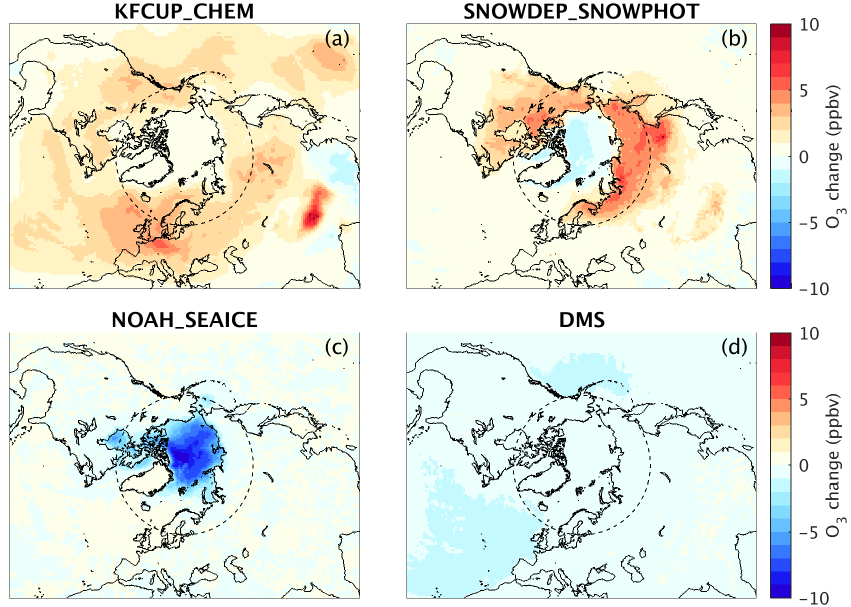
Figure 8. Change in the April to July average surface ozone due to (a) KF-CuP cumulus effect on aerosol and trace gases, (b) improved trace gas deposition over snow and improved UV albedo for photolysis over snow and ice, (c) sea-ice-melt heat sink in the Noah LSM, and (d) DMS emissions and gas-phase chemistry.